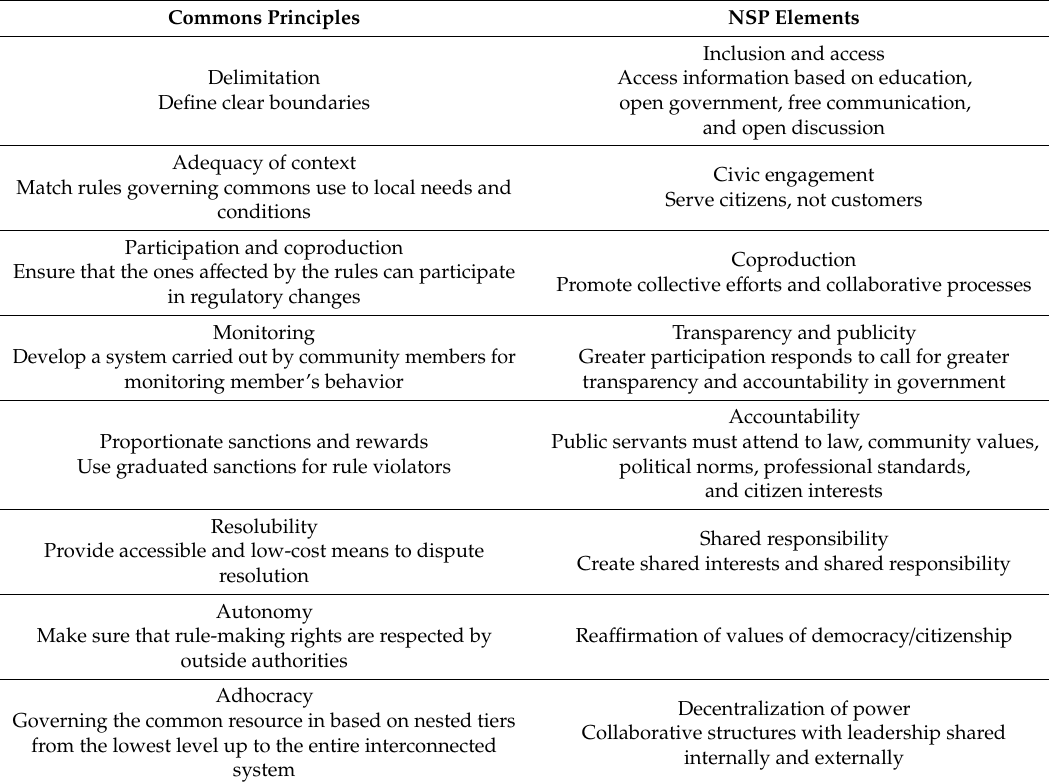
Table 2. Commons principles and New Public Service elements (derived from References